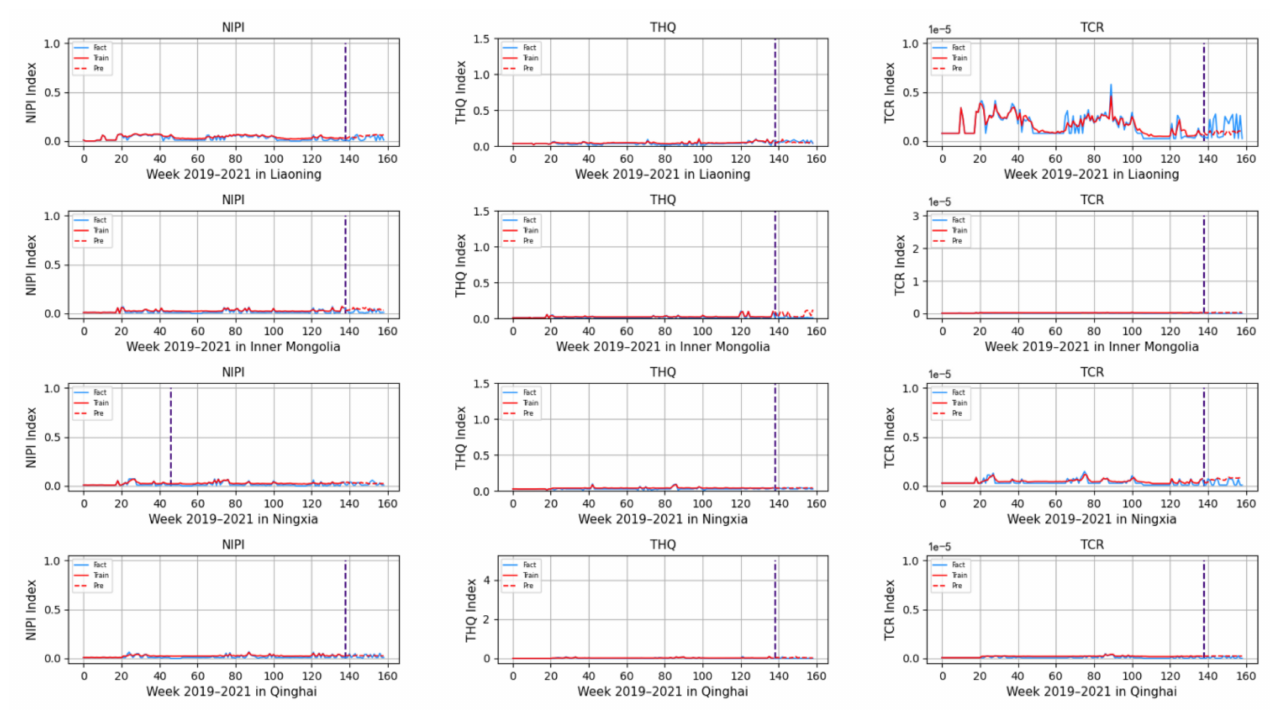
Figure 14. Predicted NIPI, THQ, and TCR indicators for Liaoning, Inner Mongolia, Ningxia, and Qinghai.